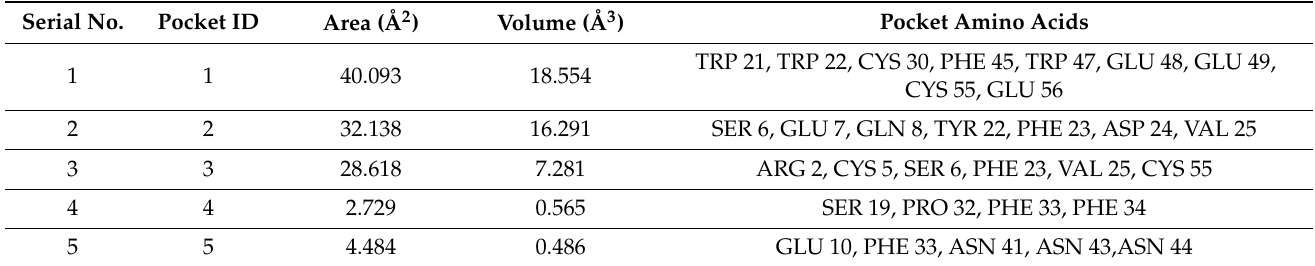
Table 3. Predicted top five ligand-binding pockets according to CASTp. Serial No.